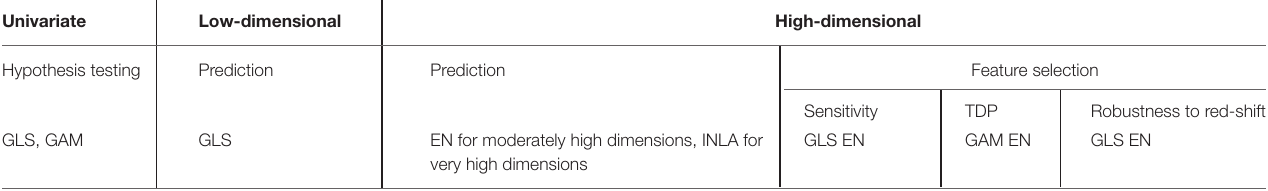
TABLE 1 | Best methods for different scenarios (first row) and criteria (second and third rows).